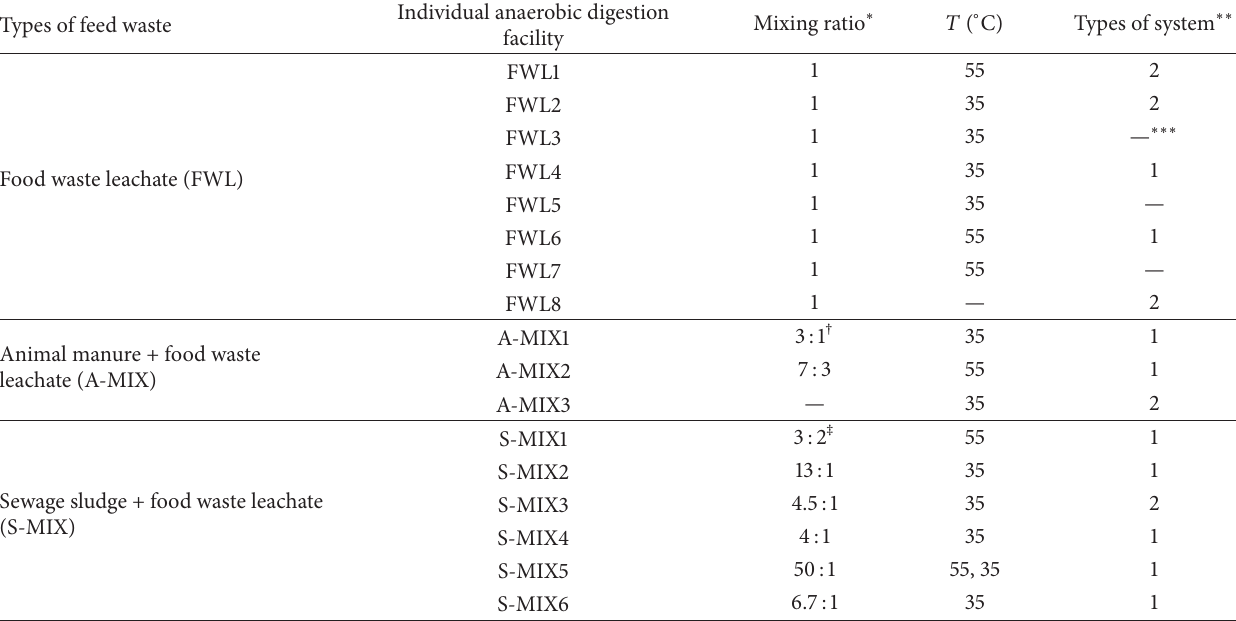
Table 1: Operating conditions of selected anaerobic digestion facilities.